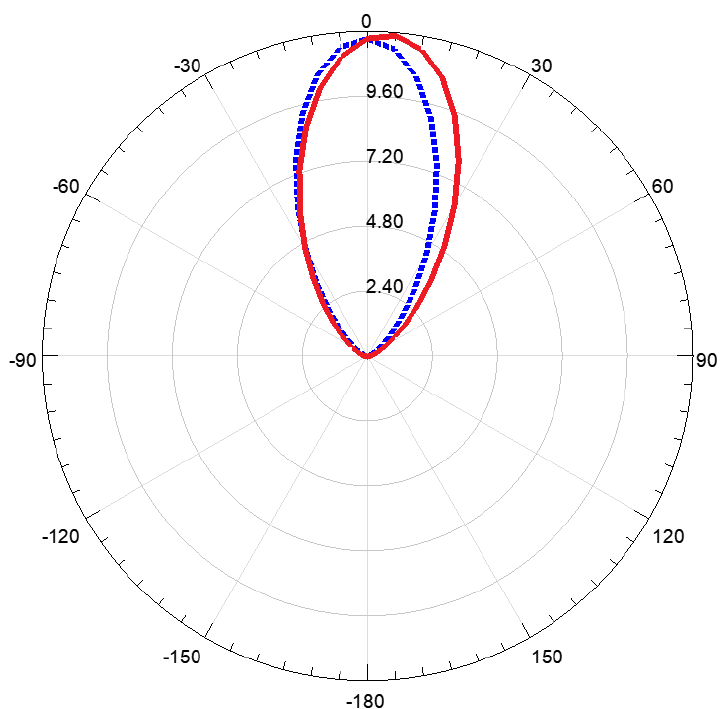
Figure 2. Antenna radiation pattern in the horizontal (dotted blue) and vertical (solid red) planes.